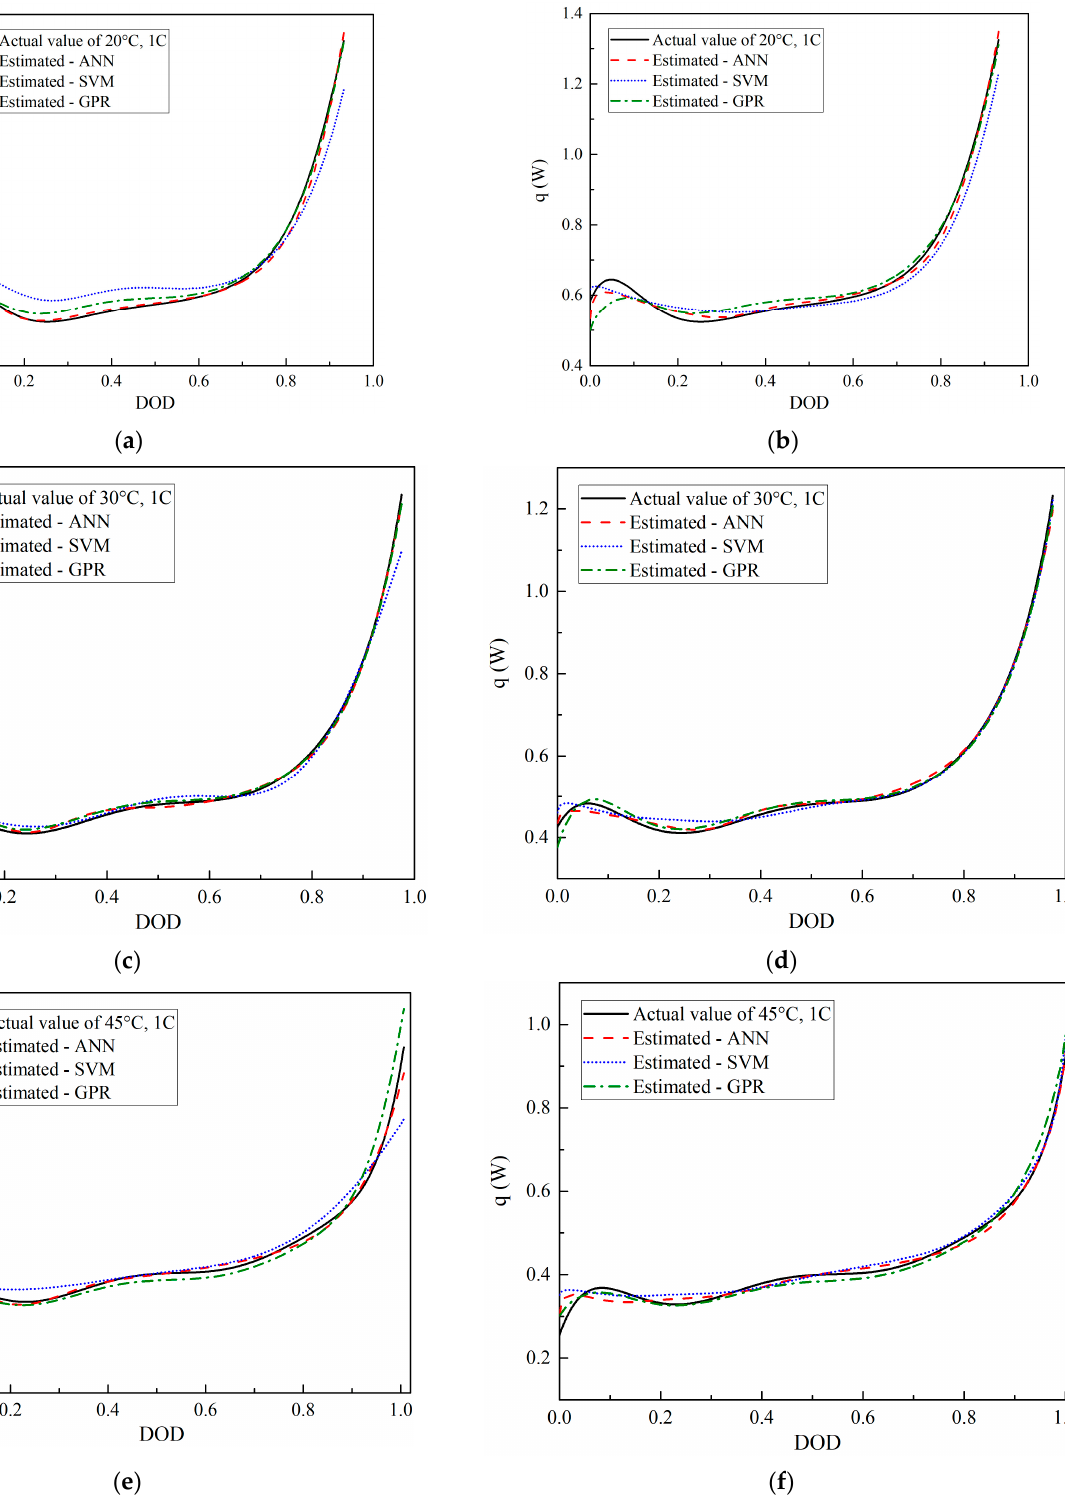
Figure 4. Comparison of the estimated and actual HGRs during discharge: ( a ) at 20 °C without discharge voltage as an input; ( b ) at 20 °C with discharge voltage as an input; ( c ) at 30 °C without discharge voltage as an input; ( d ) at 30 °C with discharge voltage as an input; ( e ) at 45 °C without discharge voltage as an input; ( f ) at 45 °C with discharge voltage as an input. Table 3. ANN architectures and covariance functions of GPR that were used, and R 2 of the regres ‐ sions.